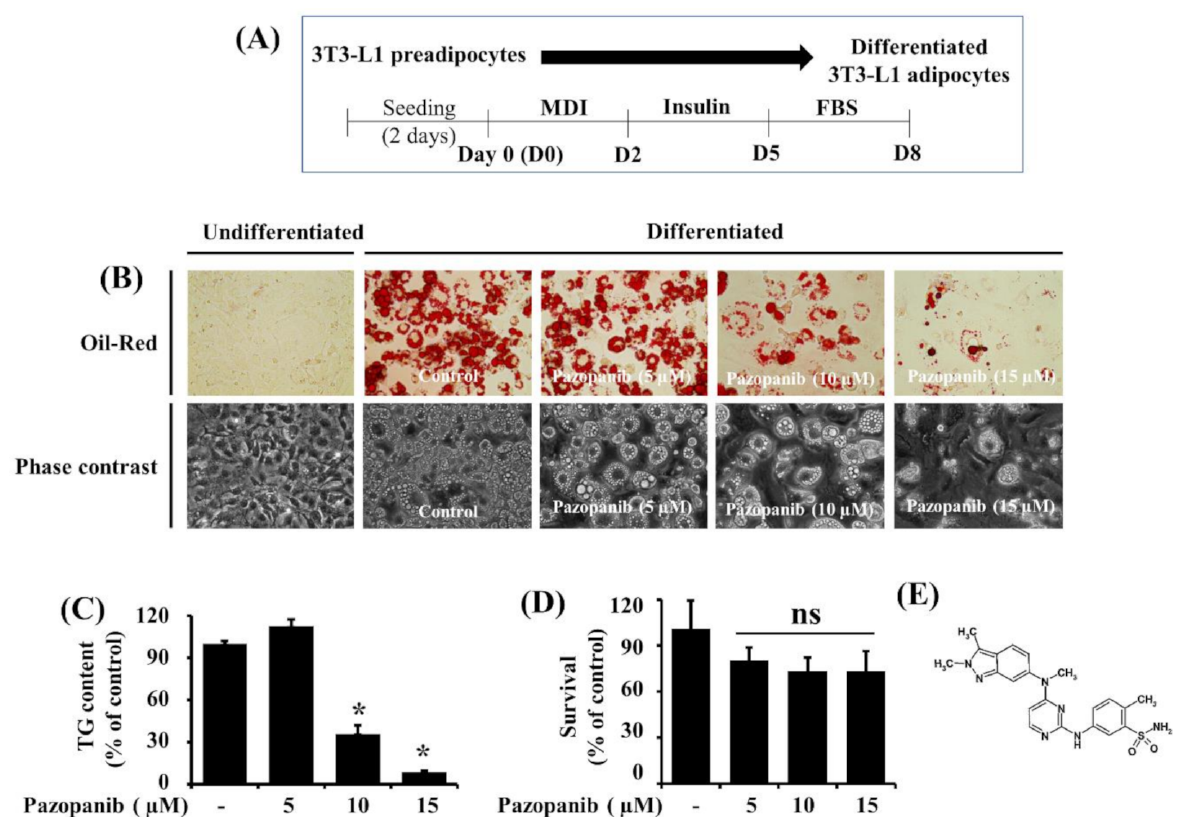
Figure 1. Effects of pazopanib on lipid accumulation, TG content, and cell growth (survival) during 3T3-L1 preadipocyte differentiation. ( A ) The experimental scheme for 3T3-L1 preadipocyte differentiation. ( B ) Measurement of intracellular lipid droplets (LDs) accumulation in undifferentiated 3T3-L1 preadipocytes on day 0 (D0) or differentiated adipocytes on day 8 (D8) in the absence (control; 0.1% DMSO) or presence of pazopanib at the designated concentrations by Oil Red O staining (upper panels) and by phase-contrast image (lower panels) at 40 × ( C ) Measurement of intracellular TG content in control or pazopanib-treated 3T3-L1 cells on D8 by AdipoRed assay. Data are mean ± SE of three independent experiments, each done in triplicate. * p < 0.05 vs. control. ( D ) Measurement of the number of live cells in control or pazopanib-treated 3T3-L1 cells on D8 by cell count assay. Data are mean ± SE of three independent experiments, each done in triplicate. ( E ) The chemical structure of